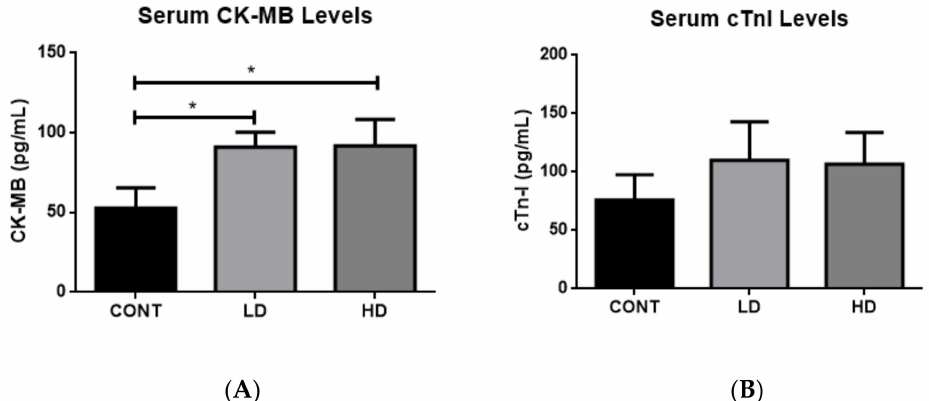
Figure 1. Serum levels of cardiac enzymes. Sera from different groups were analyzed to measure CK-MB and cTnI levels ( A , B , respectively). Data are presented as mean ± SD ( n = 5). * p < 0.05. Cont, control; LDV, low-dose venetoclax (50 mg/kg); HDV, high-dose venetoclax (100 mg/kg); CK-MB, creatine kinase-MB; cTn-I, troponin I cardiac